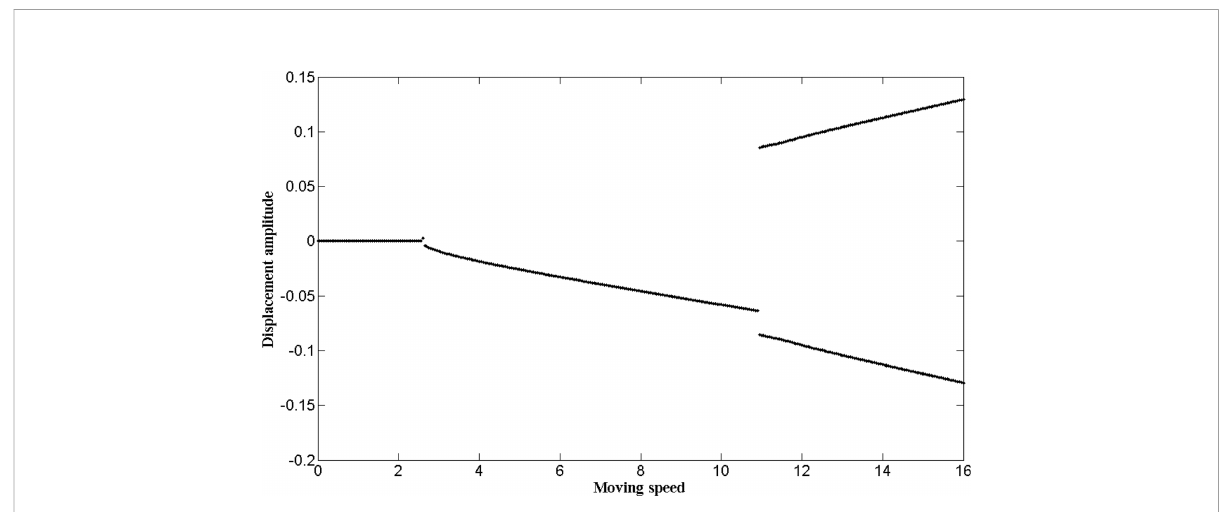
FIGURE 8 The bifurcation diagram for the midpoint of the pipe (in which u = 2 and the control parameter is the moving speed υ